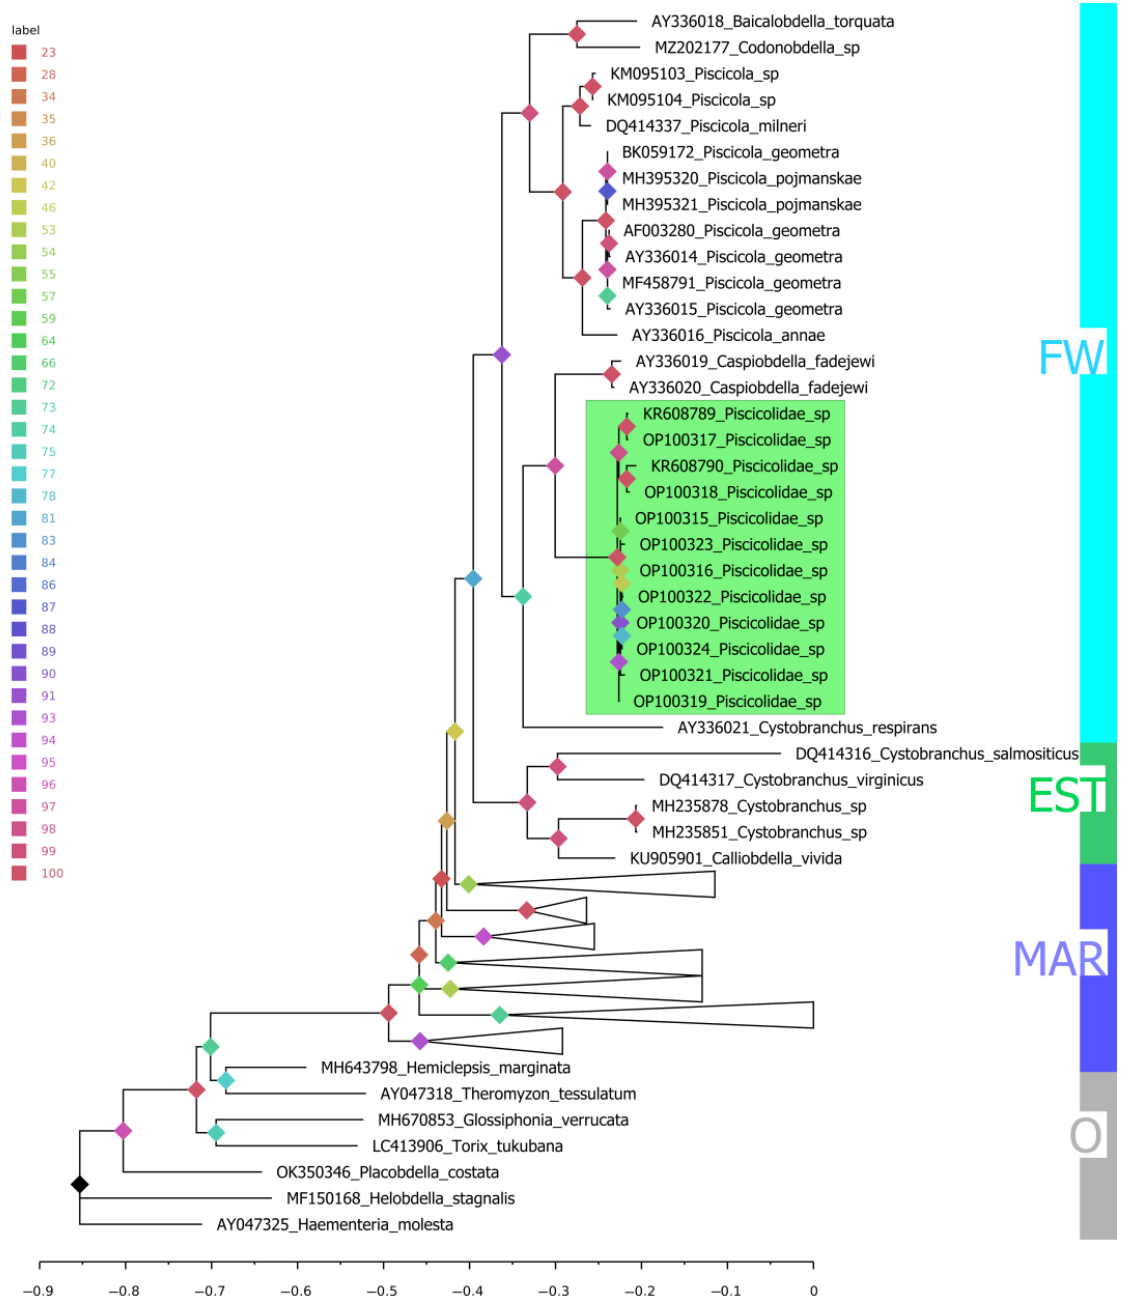
Figure 5. Maximum likelihood tree visualizing the phylogenetic position of the studied omul leeches from the Selenga River, the clade of which is highlighted in green. The colors of the labels in the tree nodes reflect the level of probability according to UFBoot [51], the values of which are deciphered in the heat map shown in the left corner. On the right, freshwater, estuarine and marine leeches, and the outgroup are marked as FW, EST, MAR and O, respectively. The phylogenetic lineages of marine leeches are presented in contracted form. A full version of this tree is shown in the Supplementary Materials (Figure S1).